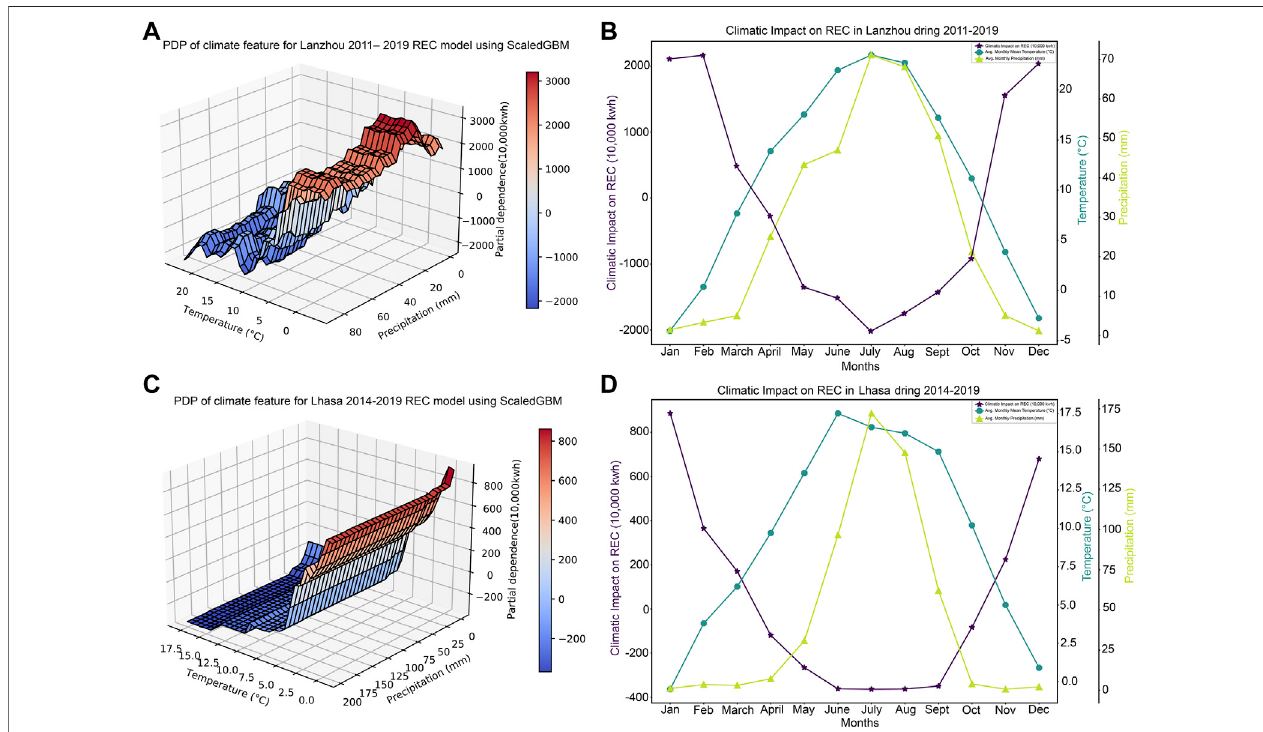
FIGURE 6 | Partial dependence plot (PDP)-based interpretation of gradient boosting machine (GBM) models for the 2011 – 2019 Lanzhou and the 2014 – 2019 Lhasa year-round datasets. Marginal effects of all climate conditions considered by the GBM model on residential electricity consumption (REC) in (A) Lanzhou and (C) Lhasa, with x -axes showing temperature, y -axes showing precipitation, and z -axes showing the marginal effect of the climate feature on the model outcome. Average climatic impacts based on climate patterns in (B) Lanzhou and (D) Lhasa, with x -axes showing the month, purple y -axes showing the marginal effect of the climate feature or climatic impact, blue y -axes showing temperature, and green y -axes showing precipitation.